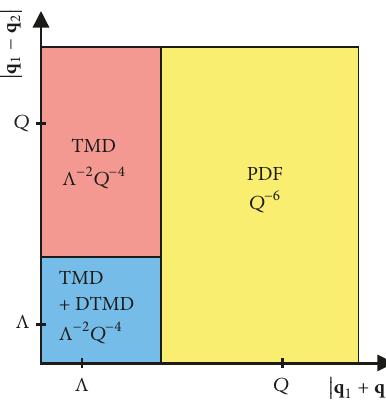
Figure 1: Transverse momentum regions and descriptions of the initial state in the leading power factorisation theorems. The power counting behaviour of the differential cross section in each region is indicated on the